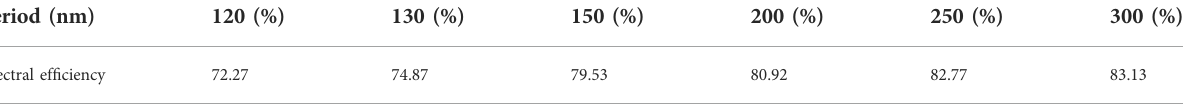
TABLE 3 Normal spectral ef fi ciency corresponding to different periods ( a = 120 nm, 130 nm, 150 nm, 200 nm, 250 nm, 300 nm). Period (nm)